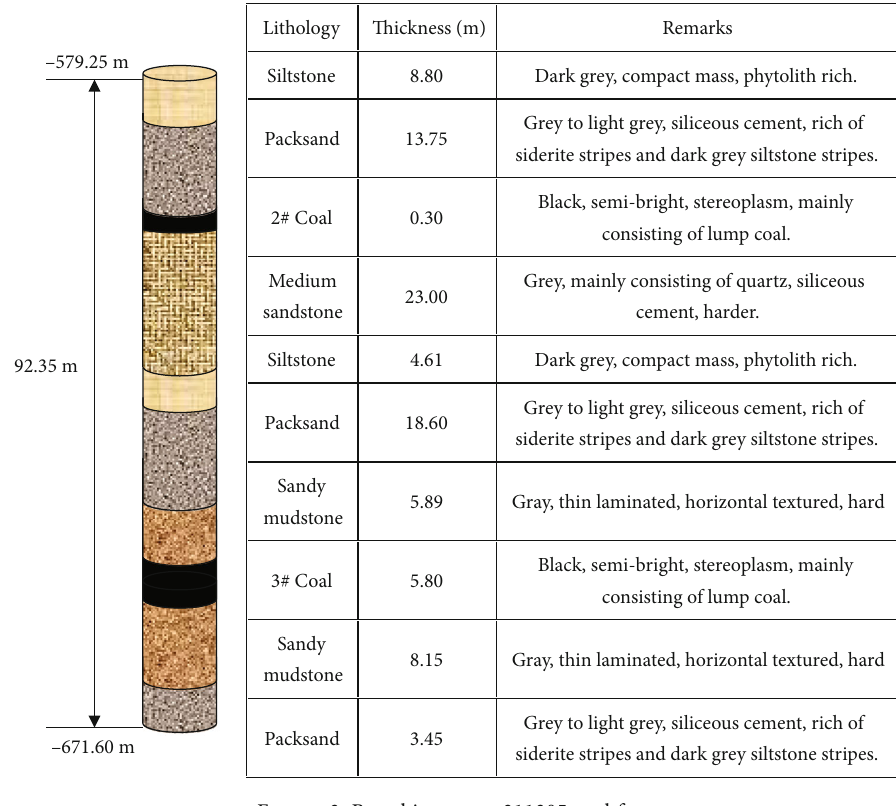
Figure 3: Bore histogram: 311305 coal face.